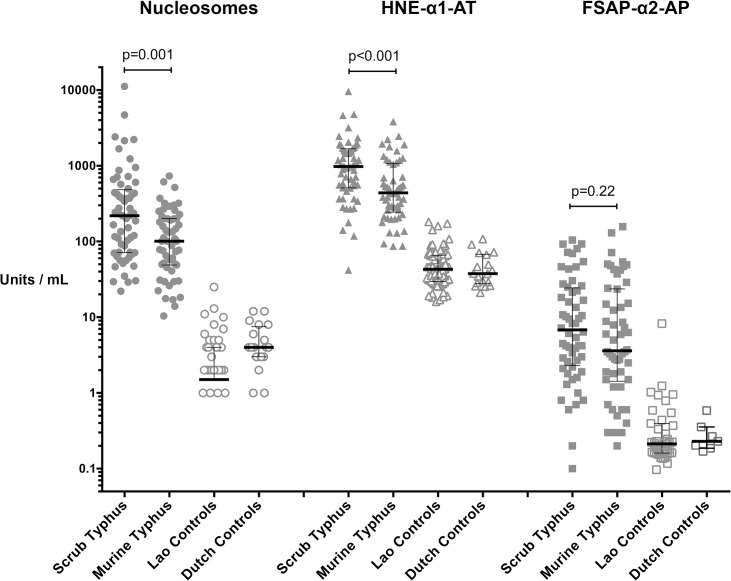
Markers of cell death and neutrophil activation in patients with scrub typhus, murine typhus and controls.Markers of cell death and neutrophil activation. Plasma levels of nucleosomes, human neutrophil elastase (ELA) complexes and Factor VII activating protease anti-plasmin complexes (FSAP) were significantly higher in patients with scrub typhus (ST) and murine typhus (MT) than in Asian (Laos) and Caucasian (Dutch) controls (p-values all <0.0001). On comparison between ST and MT, the nucleosome and ELA-complex plasma levels were significantly higher in ST than in MT, but not the FSAP levels. Data are expressed as median with interquartile range (whiskers) of admission samples.